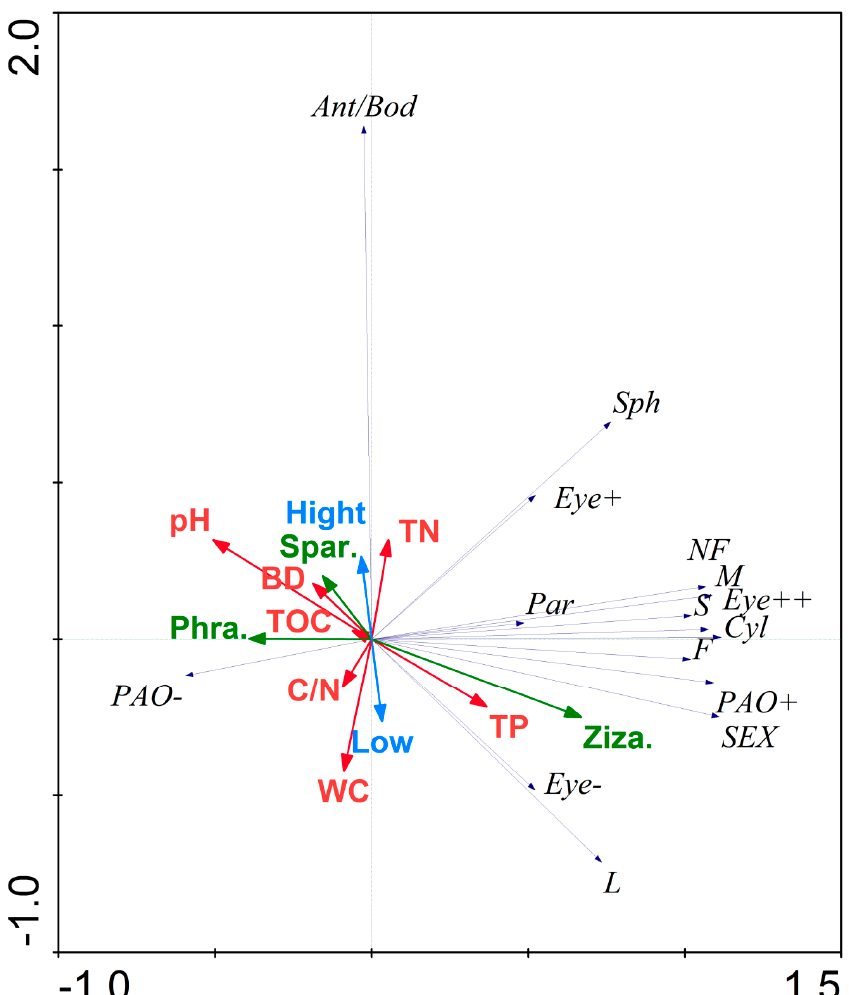
Figure 7. Parameter ordination of the environmental factor-species linear model-redundancy anal- ysis. Blue arrow: tidal flat, high tidal flat (High), and low tidal flat (Low). Green arrow: plants, Zizania latifolia (Ziza.), Phragmites australis (Phra.), and Spartina alterniflora (Spar.). Red arrow: physic- ochemical properties, water content (WC), bulk density (BD), power of hydrogen (pH), total nitrogen (TN), total phosphorus (TP), total organic carbon (TOC), and carbon-nitrogen ratio (C/N). Thin Blue arrow: functional traits.